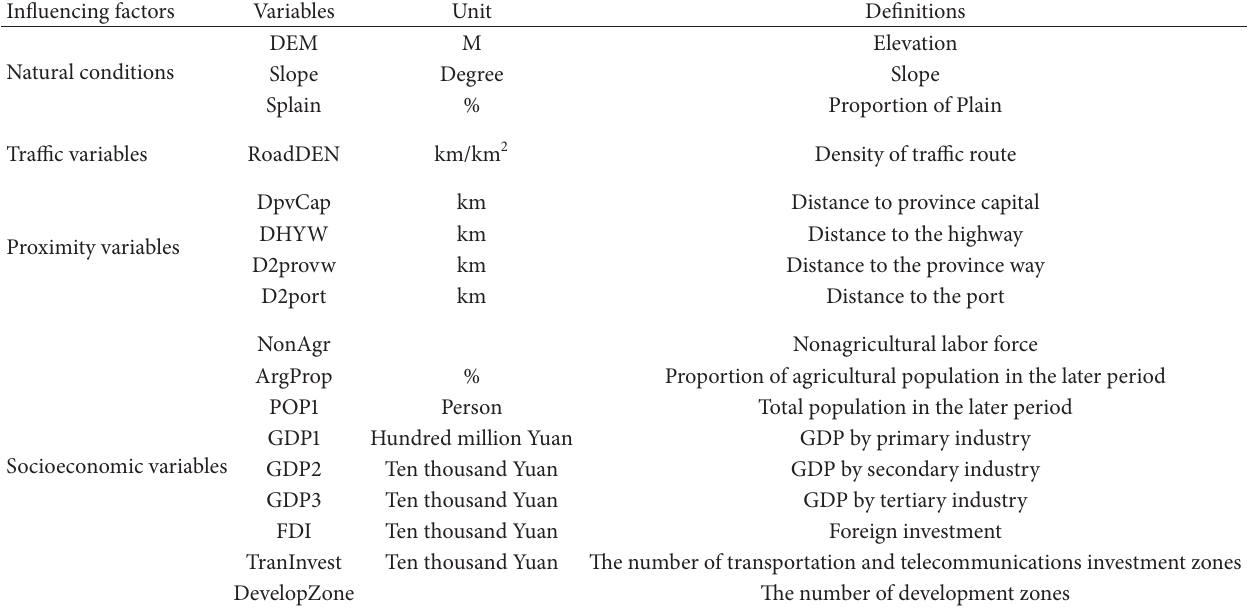
Table 1: Influencing factors of land uses considered in the DLS model in the case study.